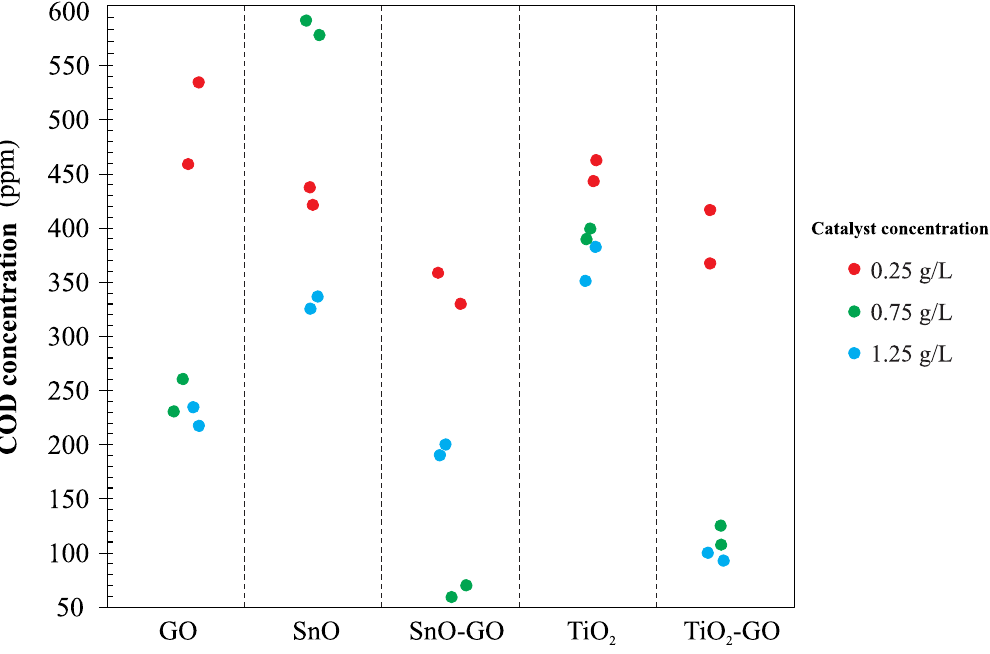
Figure 11. Concentration of COD in the effluent after photocatalytic treatment with each one of the catalysts synthesized.